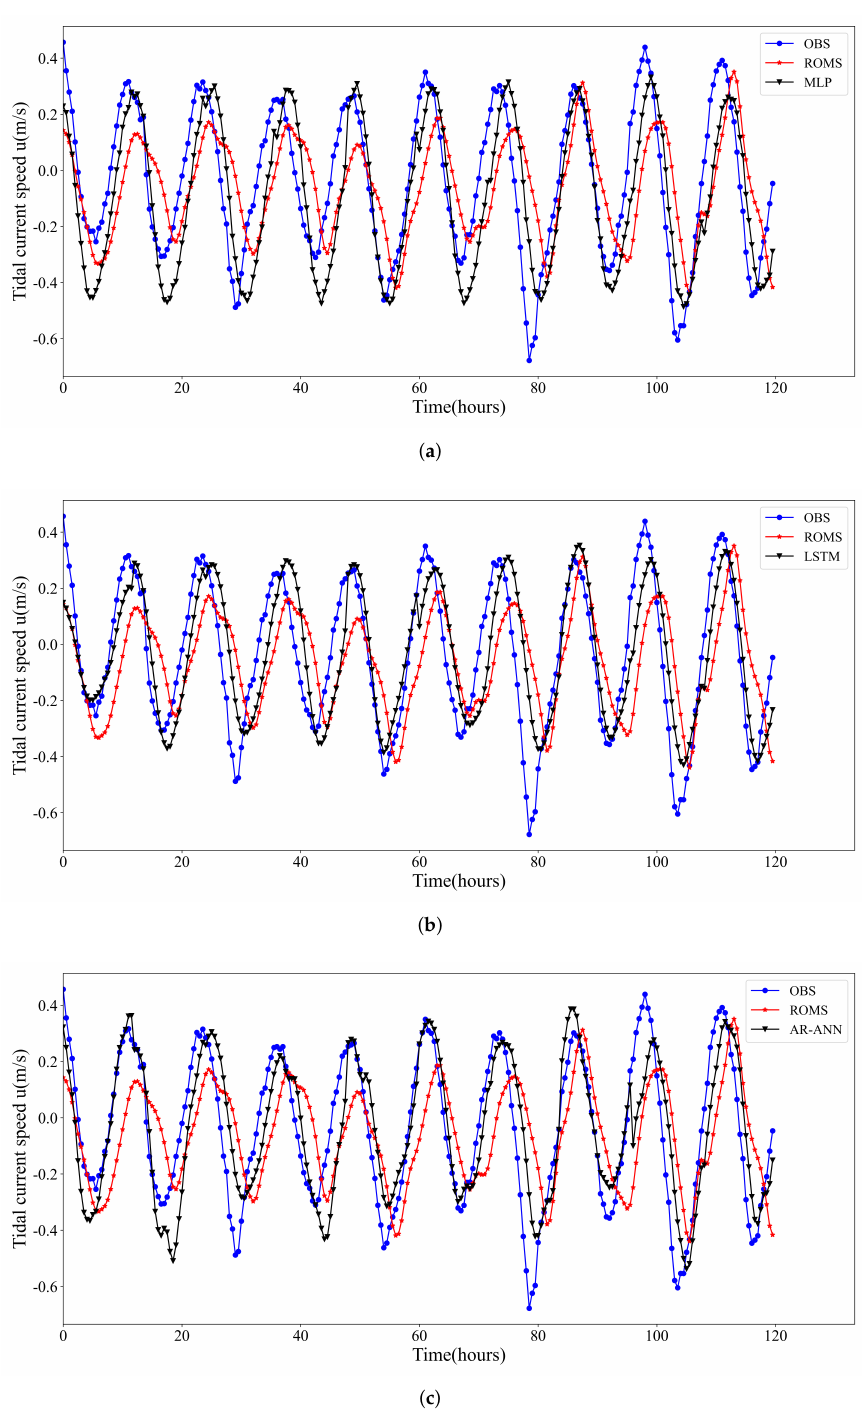
Figure 8. Comparison results of the tidal current speed bias correction by using the three machine learning algorithms. ( a ) Comparison of the MLP method, simulation data and actual value; ( b ) com- parison of the LSTM method, simulation data and actual value; ( c ) comparison of the AR-ANN method, simulation data and actual